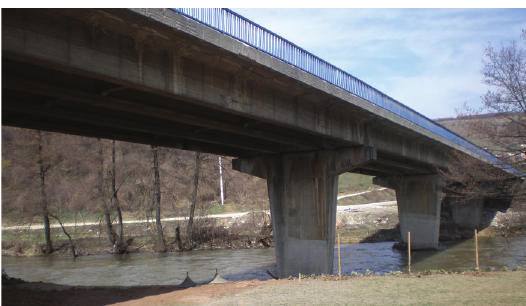
Figure 1: The bridge over river Bosnia, close to Sarajevo.